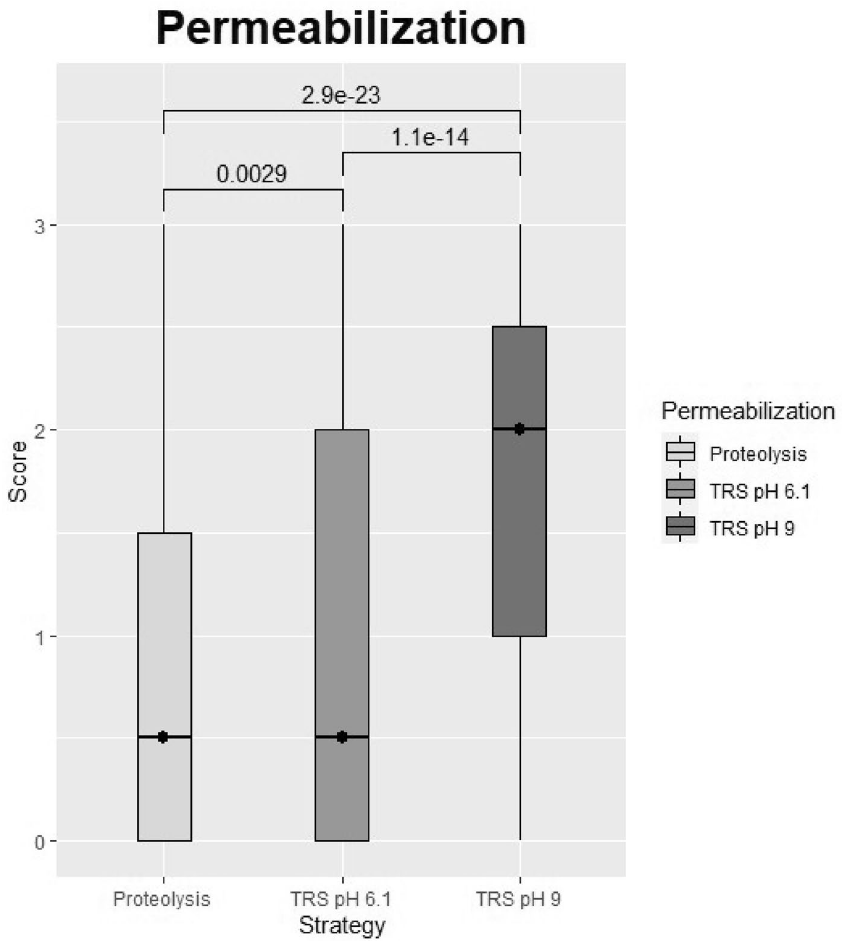
Figure 5. Overall permeabilization strategies. Proteolysis covers all treatment with proteinase K, regardless of the duration of exposure (2.5–20 min). TRS pH 6.1 = Heat-induced microRNA Retrieval (HmiRR) with Target Retrieval Solution (TRS) pH 6.1 regardless of enzymatic treatment with pepsin. TRS pH 9 = HmiRR with TRS pH 9 regardless of enzymatic treatment with pepsin. All horizontal bars indicate statistical comparison of groups. The numbers above the horizontal bars are p values determined using a Wilcoxon signed-rank test. The figure was constructed with the statistical software